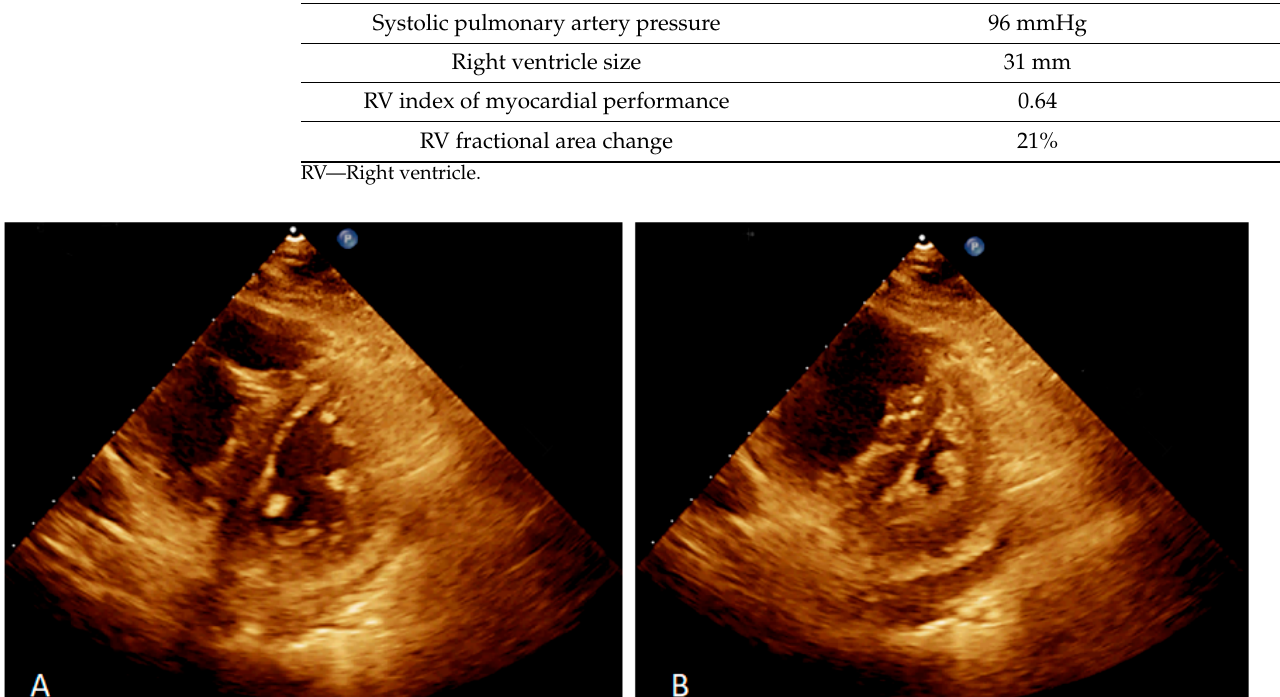
Table 3. Timeline of the patient’s treatments.